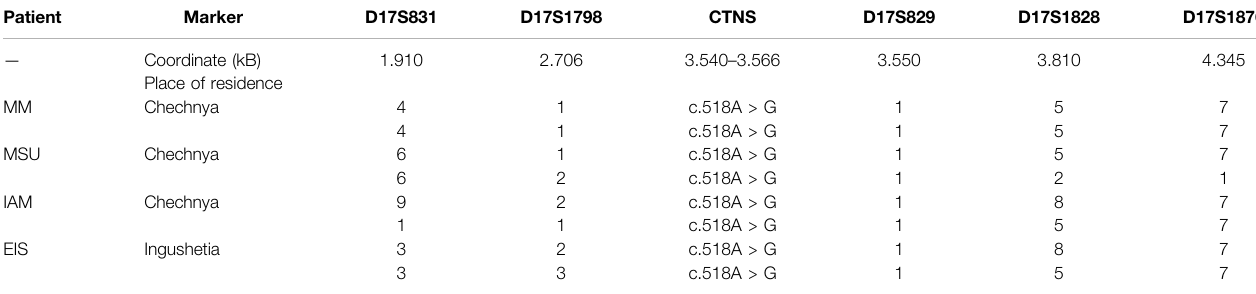
TABLE 5 | Haplotypes of chromosomes with the c.518A > G mutation for markers D17S831-D17S1798-D17S829-D17S1828-D17S1876. Patient Marker